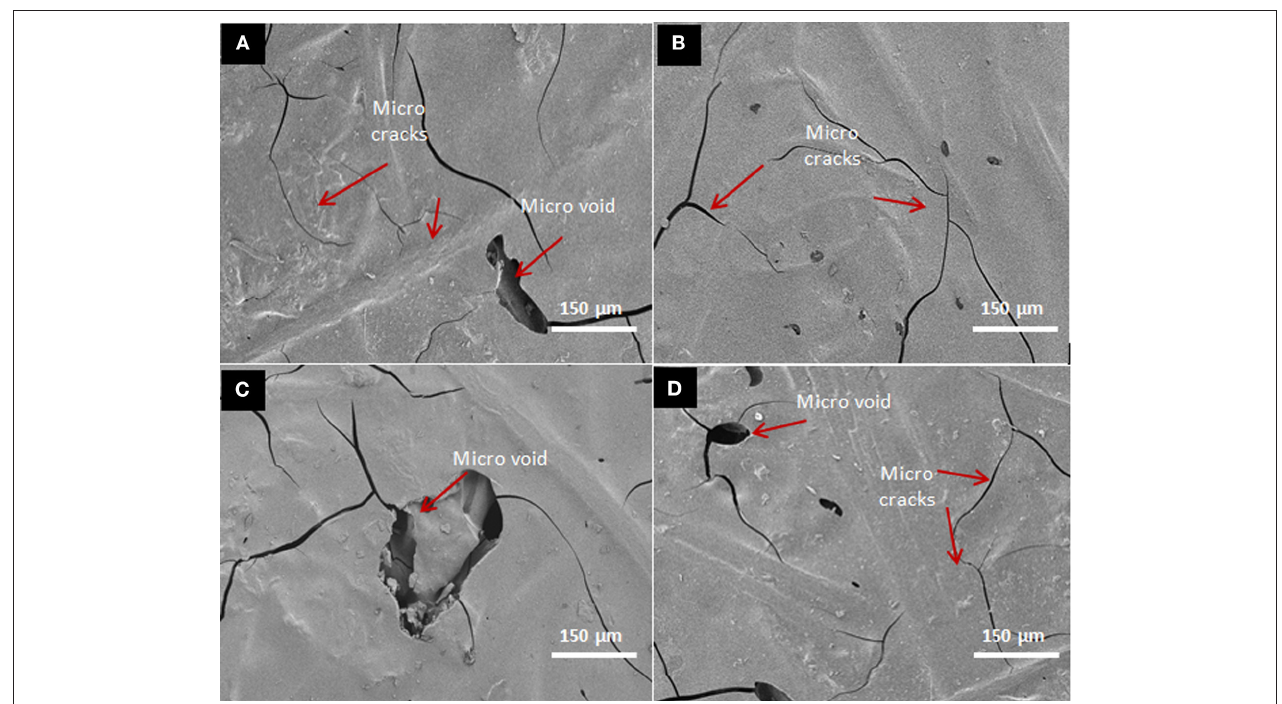
FIGURE 8 | SEM images of composites surfaces after water absorption test (A) UTKC, (B) ATKC, (C) AHTKC, and (D) HTKC.